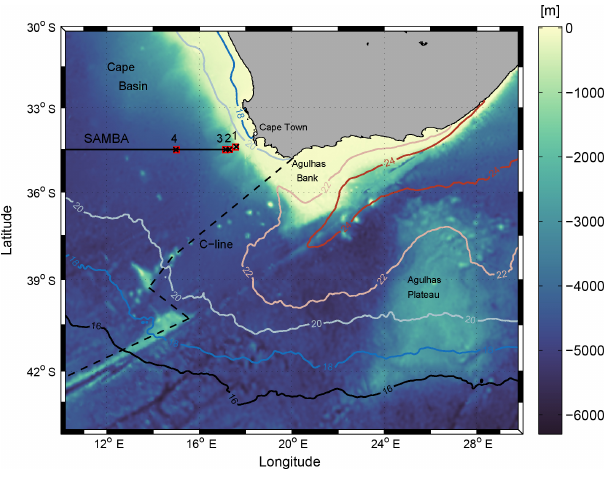
Figure 1. Study area with shaded color representing the bathymetry (m) from ETOPO1. The thin black line denotes the position of the SAMBA-east transect and the black crosses (red squares) represent the mooring (CPIES) positions with their associated numbers (1, 2, 3 and 4). The dotted black line denotes the C-line position. Annu- ally averaged 2015 SST isotherms from the ODYSSEA data set are plotted with colored